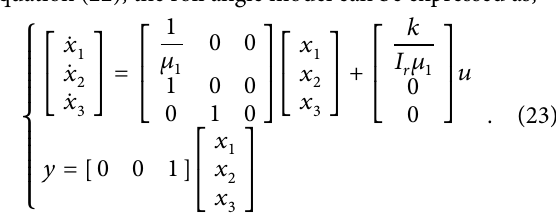
Table 1: Constants of quad-rotor